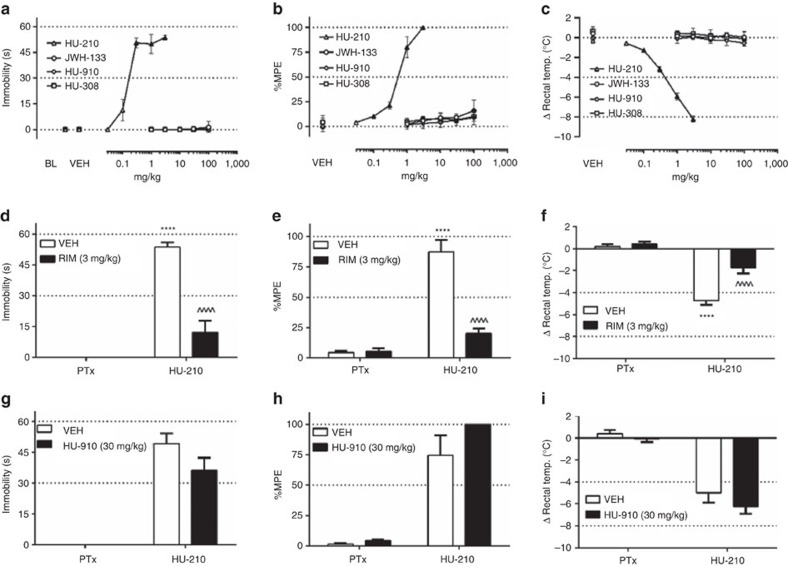
Comparison of in vivo cannabimimetic pharmacological effects.HU210 dose-dependently elicited catalepsy (a), antinociception (b) and hypothermia (c), but HU308, HU910 and JWH133 lacked appreciable pharmacological effects in each assay. Whereas pretreatment with SR141716A (3 mg kg−1) attenuated the magnitude of cataleptic (d), antinociceptive (e) and hypothermic (f) effects of HU210 (1.7 mg kg−1), HU910 did not significantly reduce HU210-induced catalepsy (g), antinociception (h) or hypothermia (i). Filled symbols denote significance versus the respective vehicle injection for each drug (a–c). ****P<0.0001 HU210 versus respective pretreatment (PTx) (Holm-Sidak's test). ^^^^P<0.0001 versus vehicle/HU210 (Holm-Sidak's test). Sample sizes=8 mice/group (a–c) and 6 mice/group (d–i). All values reflect mean ± s.e.m.